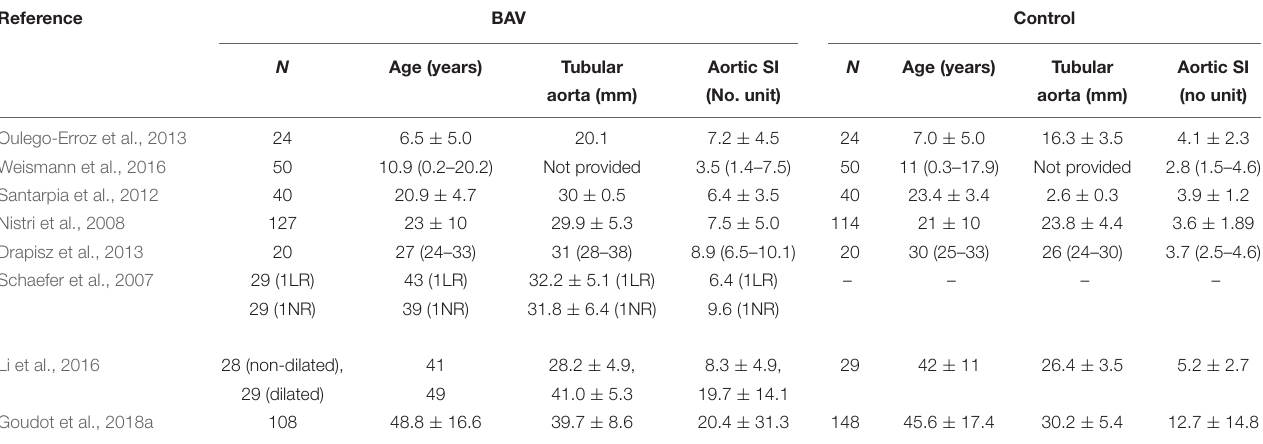
TABLE 1 | Results of ultrasonic stiffness evaluation (stiffness index, SI) at the tubular aortic level. Reference